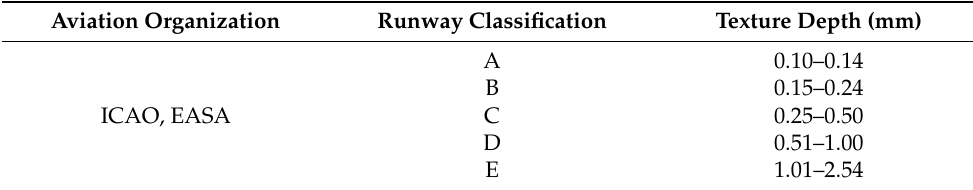
Table 5. Texture depth requirements for airfield pavements in